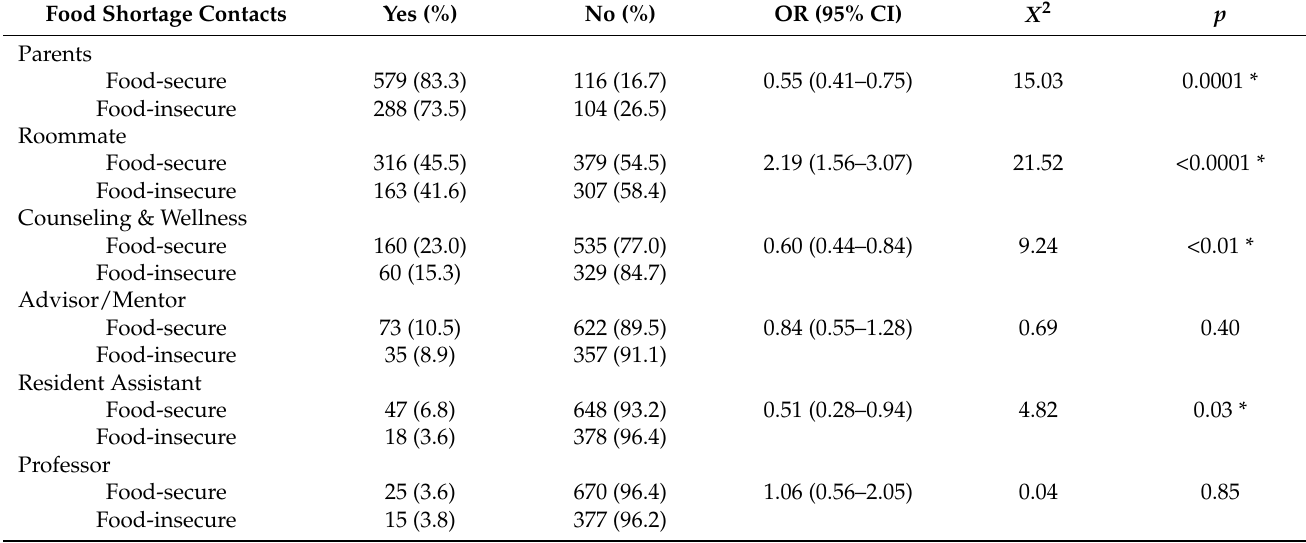
Table 3. Chi-square analysis of contacts for college students if experiencing a food shortage, by food security